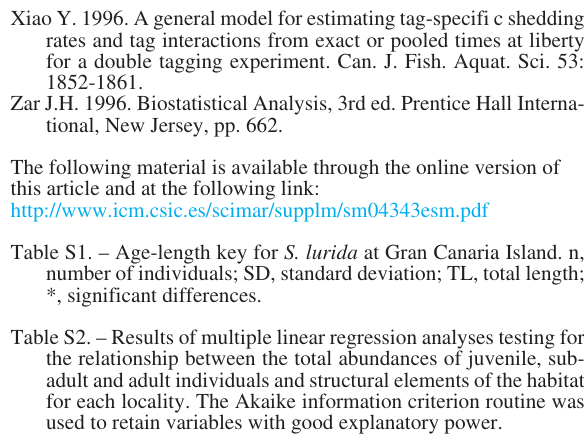
Table S1. – Age-length key for S. lurida at Gran Canaria Island. n, number of individuals; SD, standard deviation; TL, total length; *, significant differences. Table S2. – Results of multiple linear regression analyses testing for the relationship between the total abundances of juvenile, sub- adult and adult individuals and structural elements of the habitat for each locality. The Akaike information criterion routine was used to retain variables with good explanatory